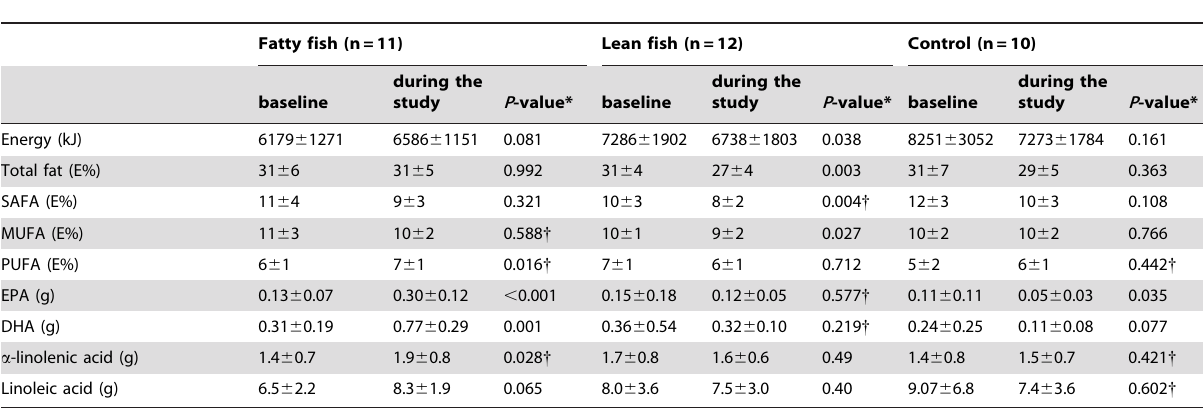
Table 2. Daily dietary intakes at baseline and during the study (mean 6